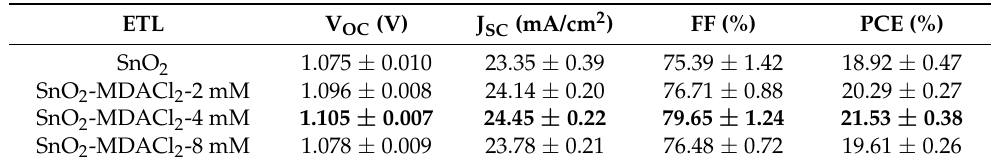
Figure 1. ( a ) Schematic diagram of the glass/FTO/SnO 2 /Perovskite/Spiro/Au PSC structure. ( b ) V OC , ( c ) J SC , ( d ) FF, and ( e ) PCE distributions of PSCs prepared under conditions of different MDACl 2 concentrations. The data were collected from 20 devices for each condition. Table 1. Statistic photovoltaic parameters of PSCs prepared under conditions of different MDACl 2 concentrations.